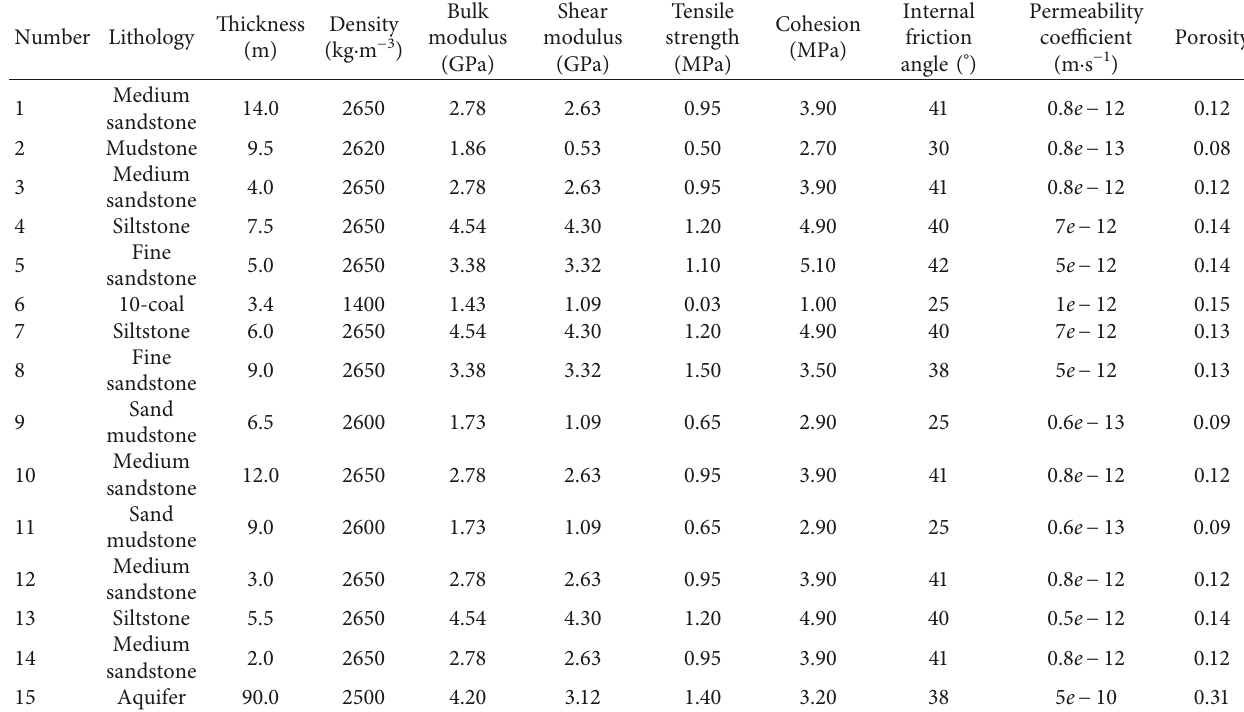
Table 1: Physical and mechanical parameters of the roof and floor strata of the 1066 inclined coal seam workface. Thickness Number Lithology